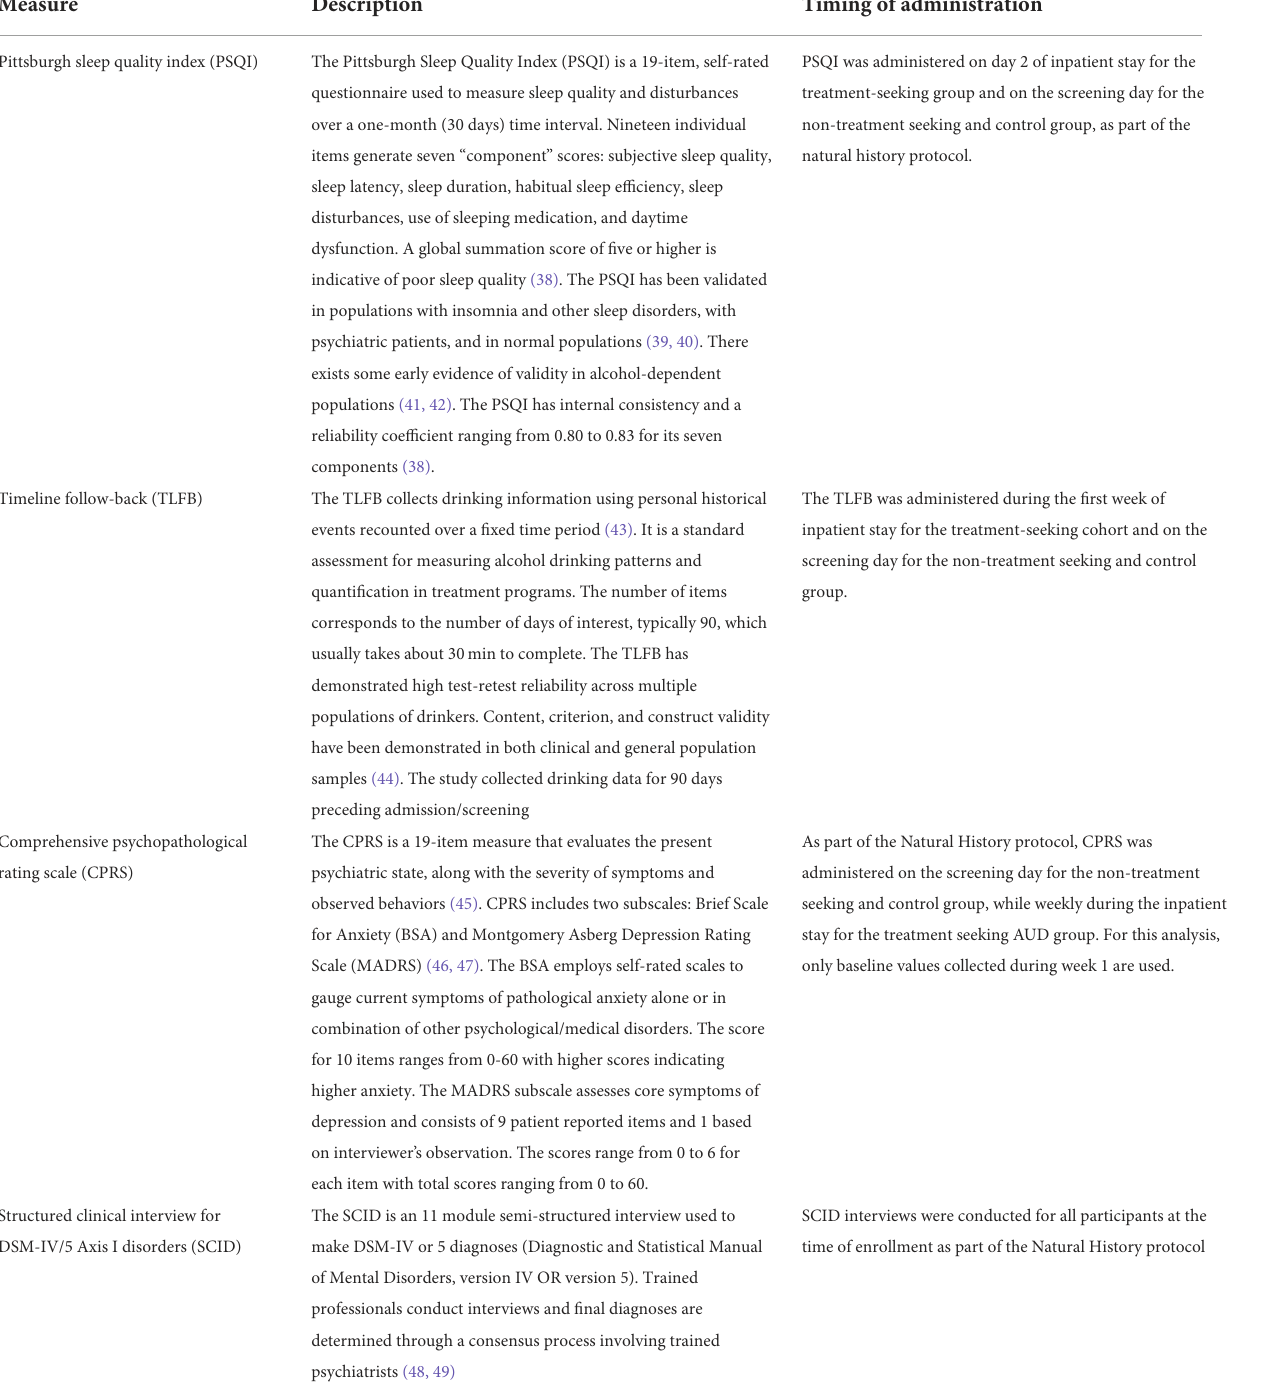
TABLE 1 Description and administration of study